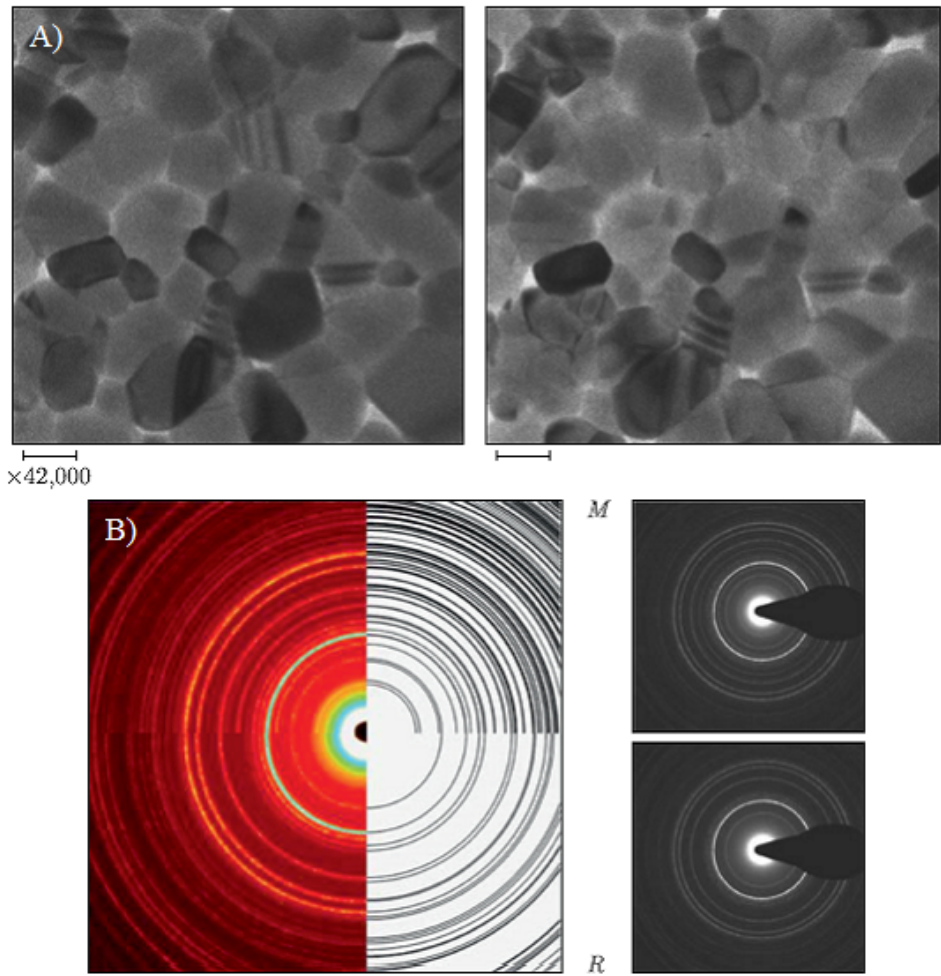
Figure 2. ( A ) Images obtained by the ultrafast electron microscopy (UEM) method before the phase transition in VO 2 films (left) and after the phase transition (right). The magnification is 42,000 × (scale 100 nm). It should be noted that these images would not be observed if the femtosecond pulses for the generation of photoelectrons were blocked. ( B ) Diffraction patterns obtained by the UEM method before the phase transition in VO 2 (right) and after it (left). Diffraction patterns of the two phases (monoclinic phase M and high-temperature tetragonal rutile phase R ) observed experimentally (on the left in panel B) and constructed as a result of calculations (on the right in panel B). The analysis was described in [38]. (Adapted from work in [38] with minor changes. Copyright (2006) National